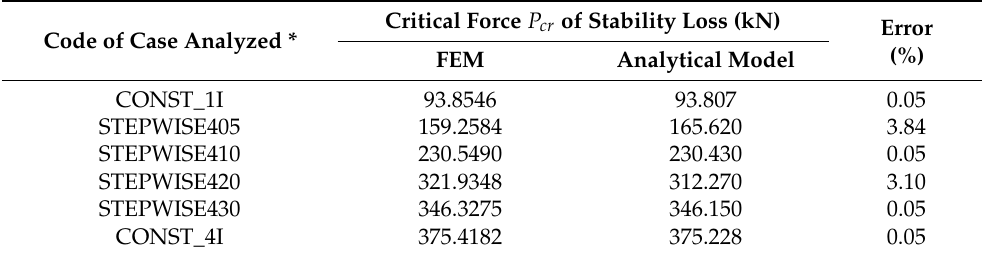
Table 3. Comparison between the critical buckling force P cr obtained by the FEM with the one obtained with the analytical model for different cases of bars involved in this research.